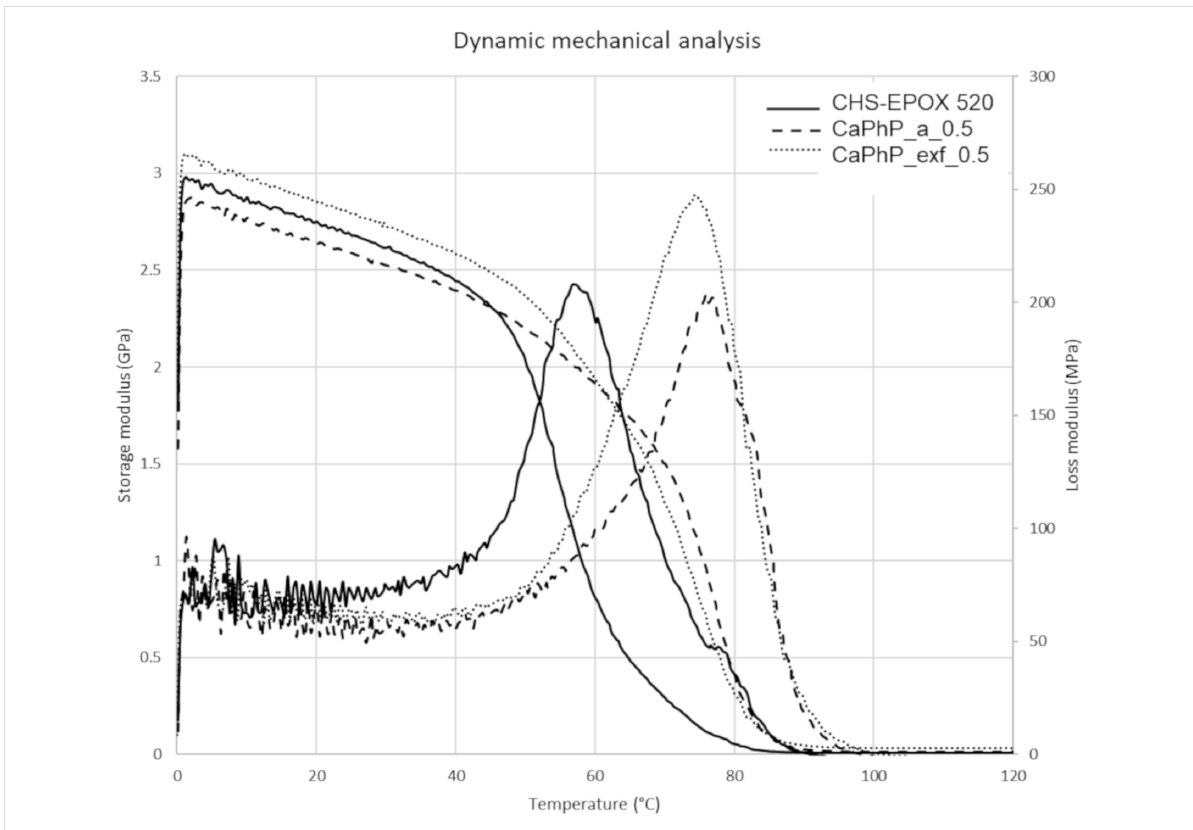
Figure 9: Storage and loss moduli measured by dynamic mechanical analysis for the pristine epoxy-free film (CHS-EPOX 520) and for free films loaded with 0.5 wt % of unexfoliated (CaPhP_a_0.5) and exfoliated (CaPhP_exf_0.5) filler.